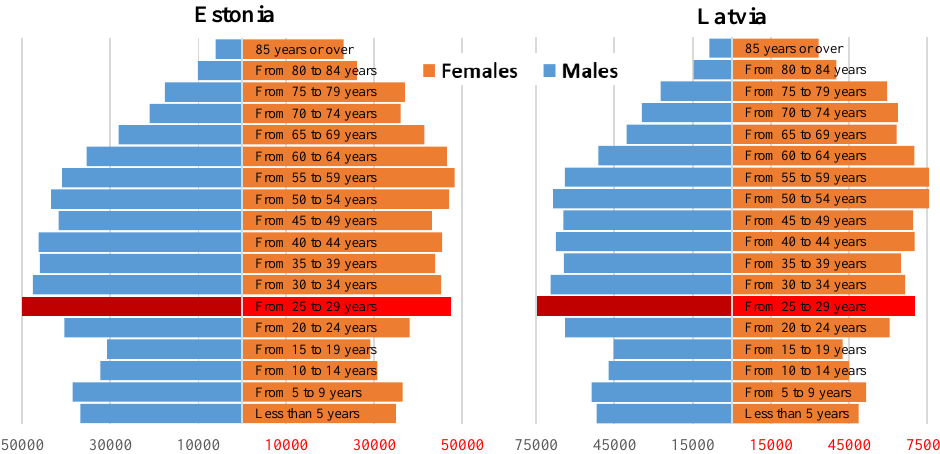
Fig. 1. Population pyramids of Estonia and Latvia as of 1 January 2015 (authors’ elaboration based on Eurostat